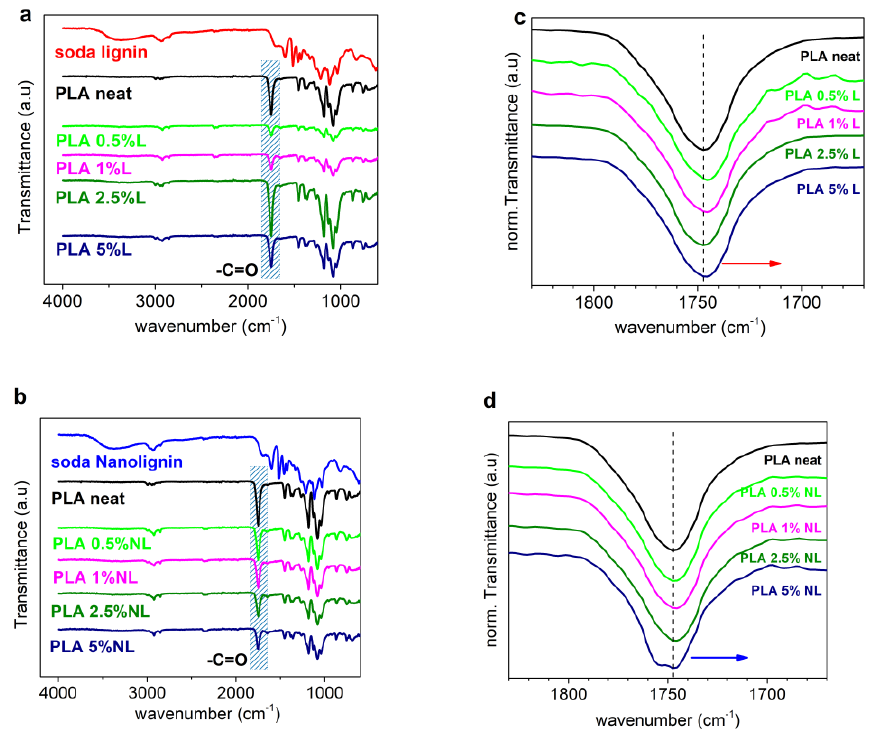
Figure 2. Comparison of the ATR − FTIR spectra of PLA and all the ( a ) PLA − L and ( b ) PLA − NL composites. Overlay of the corresponding (-C=O) peaks after intensity normalization for PLA − L ( c ) and PLA − NL composites ( d ). Red and blue arrows indicate the minor shift of composites spectra toward lower wavenumbers.